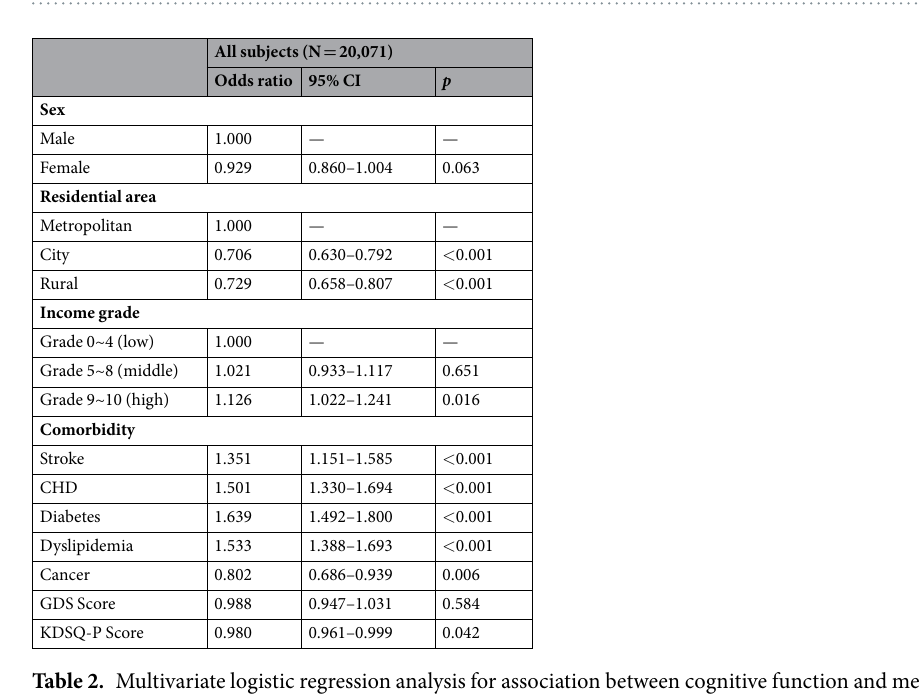
Table 1. Demographic and clinical characteristics of elderly patients with hypertension SD, standard deviation; GDS, Geriatric Depression Screening (range 0–3); KDSQ–P, Prescreening Korean Dementia Screening Questionnaire (range 0–10). * Column percentage; ** Row percentage.